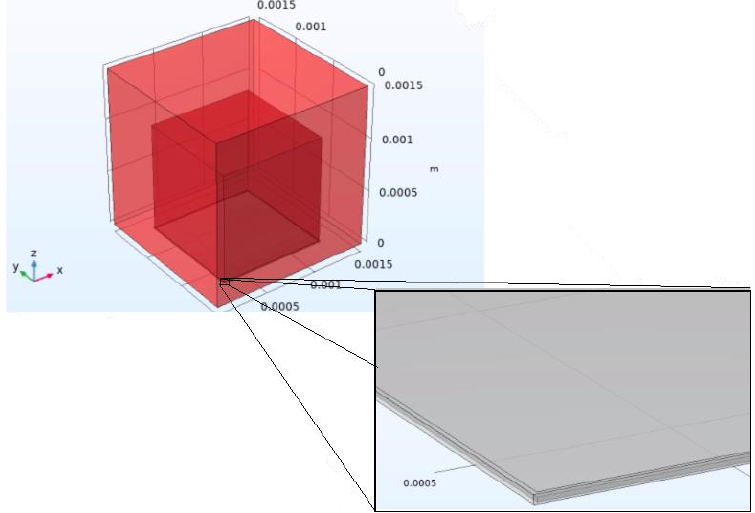
Figure 17. Example of geometry designed in a simulation tool.